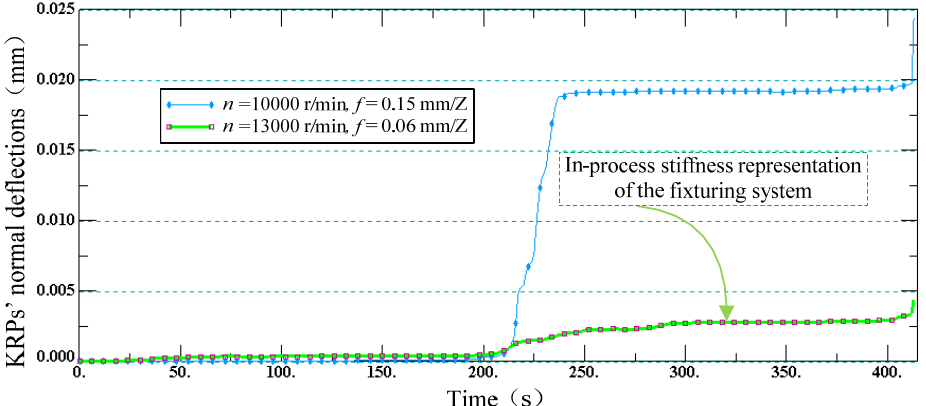
Table 2. Optimized process scheme. Figure 6. KRPs’ normal deflections of milling parameters with layout #2 and trimming route #2. Clearly, after the optimization prediction, it can be seen that the cliff effects of the in- process dynamic stiffness almost disappeared and the standard deviation of KRPs’